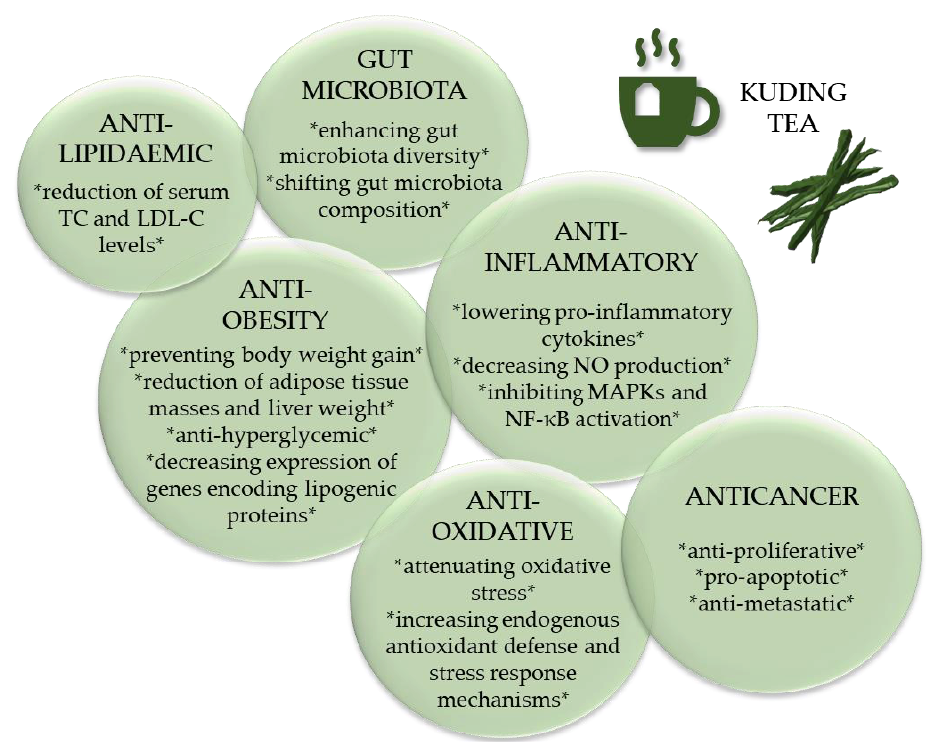
Figure 7. Bioactivity of Kuding tea and its constituents. LDL-C, low-density lipoprotein-cholesterol; MAPK, mitogen-activated protein kinase; NF- κ B, nuclear factor- κ B; NO, nitric oxide; TC, total cholesterol; * * bullet points.